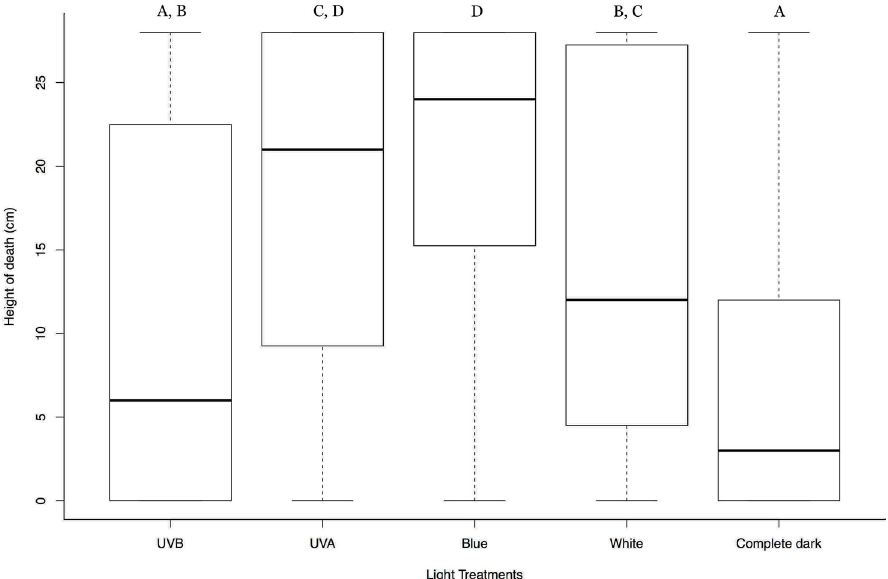
Figure 1. Box plots summarizing the vertical position of the HearNPV infected H. armigera larvae at death in different light treatments from above. Y-axis represents the vertical position of the dead larvae from the base of the cylinder in centimeter (cm); X-axis represents different light treatments; In each box plot, the heavy horizontal line crossing the box is the median, the bottom, and top of the box are the lower and upper quartiles, and the whiskers are the minimum and maximum values. Clusters with the same letter code are not significantly different.